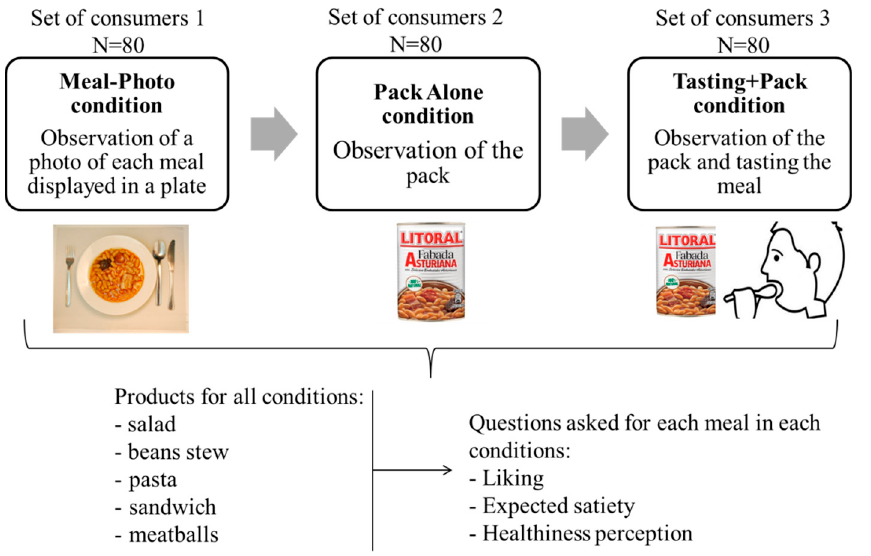
Figure 1. Scheme of the experimental procedure where three different sets of consumers participated in one of the three different conditions and evaluated five meals. Table 2. Photographs of the ready-to-eat meals presented to the participants (Meal-photo condition).